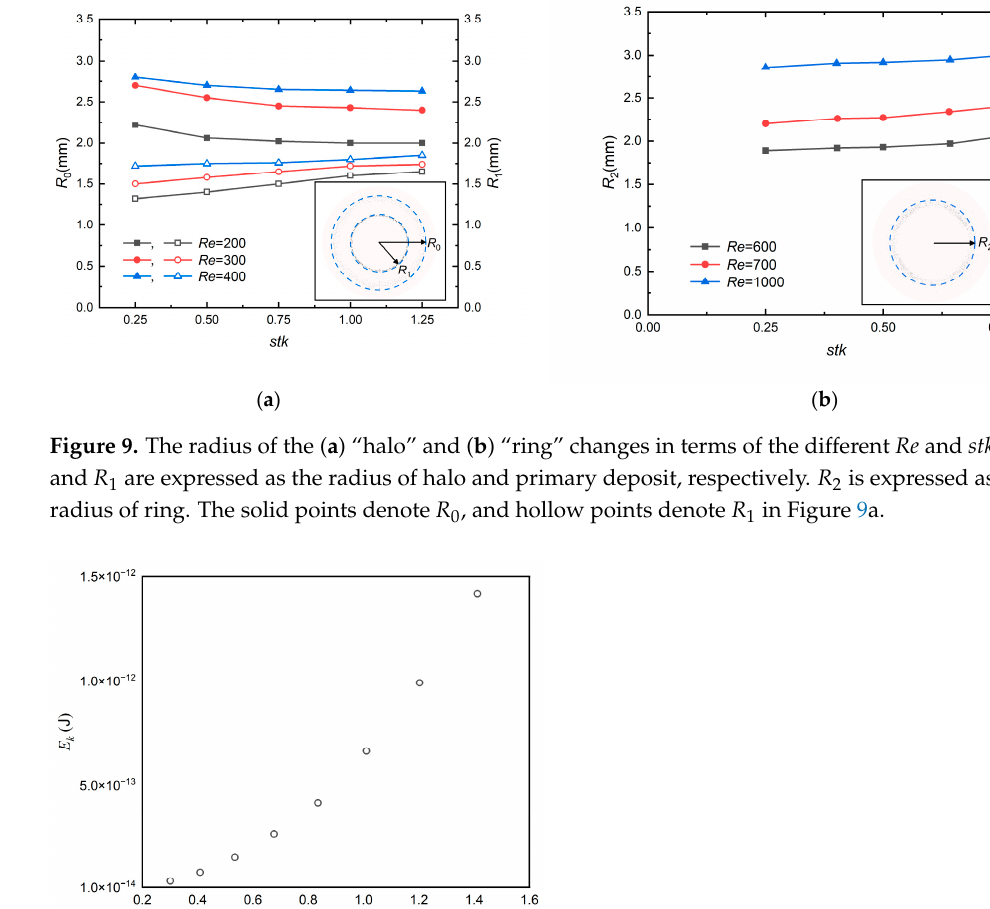
Figure 10. The E k of particles released at the same initial position for different stk in the same y coordinate in the upstream surface of the plate. Micromachines 2022 , 13 , x